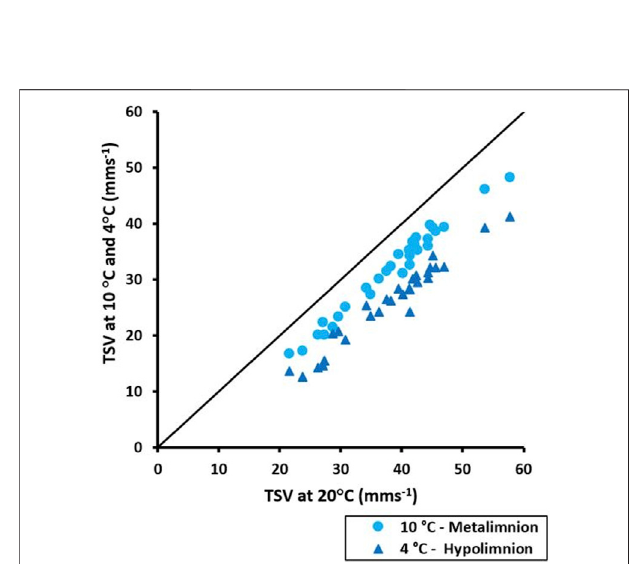
FIGURE 10 | Effects of water temperature changes in a strati fi ed lake assumingatemperatureof20 ° Cintheepilimnion,10 ° Cinthemetalimnionand 4 ° Cinthehypolimniononthesettlingvelocityof30irregularMPparticleswitha density of 1.38 gcm − 3 .